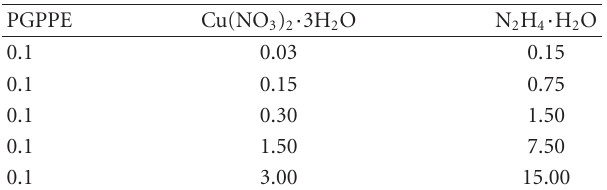
Table 1: Concentration of elements each solution with varying copper ion (unit: mol/dm 3